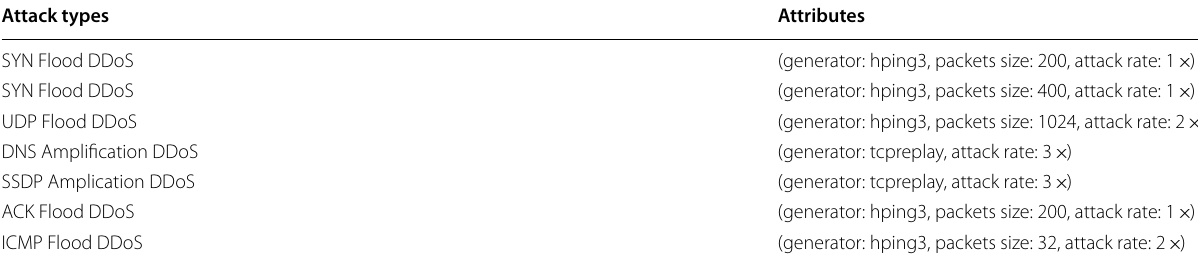
Table 1 Attack types and